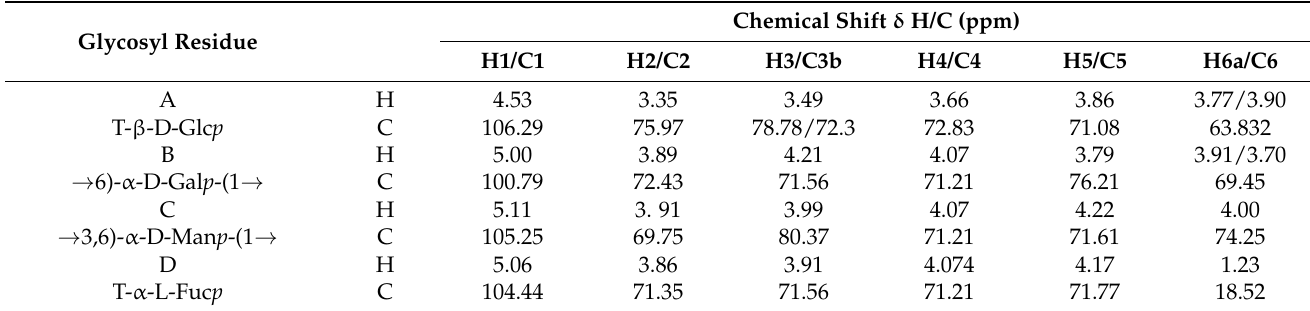
Table 4. 1 H and 13 C NMR chemical shifts of CHFVP-1 fraction recorded in D 2 O at 291 K. Glycosyl Residue